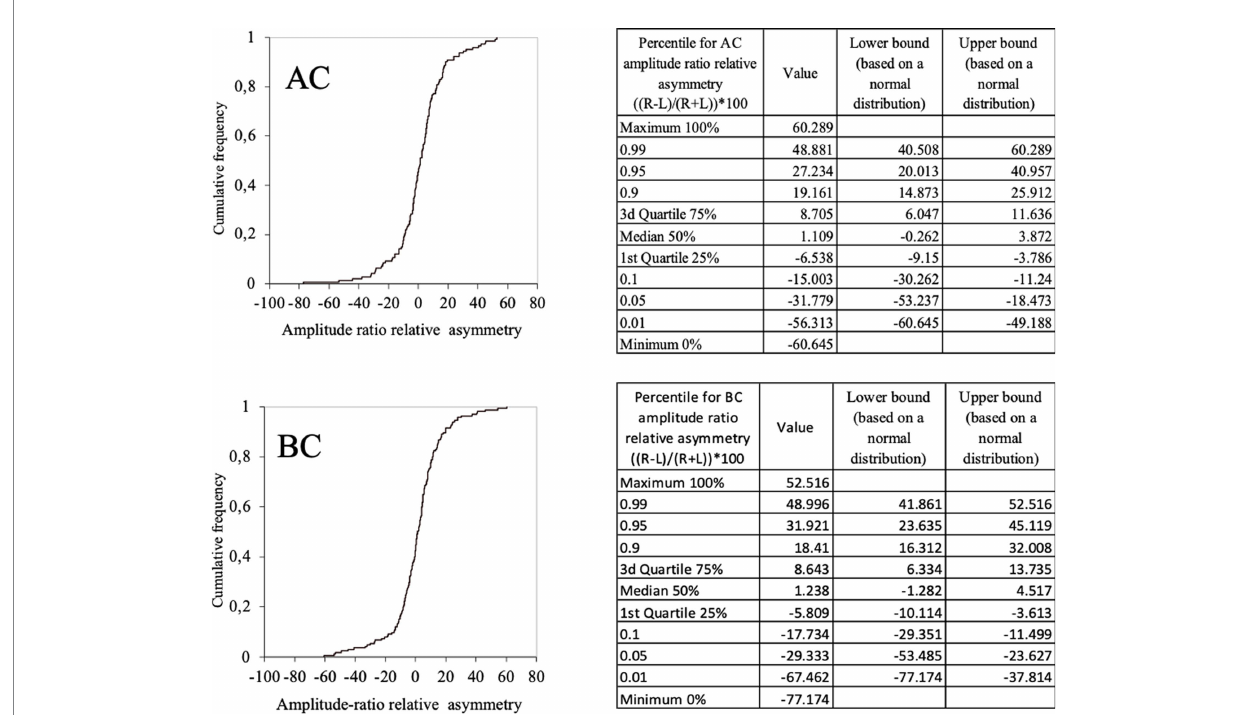
FIGURE 9 Normal values of c-VEMP amplitude ratio relative asymmetry for AC and BC for the whole population (children and adults) (cumulative histogram and tables). Relative asymmetry was calculated as follow: (((Right–Left)/(Right+Left))*100). For AC the 5–95% confidence limit values of the relative asymmetry range from [–32, 27%]. For BC the 5–95% confidence limit values of the relative asymmetry range from [–29, 32%].